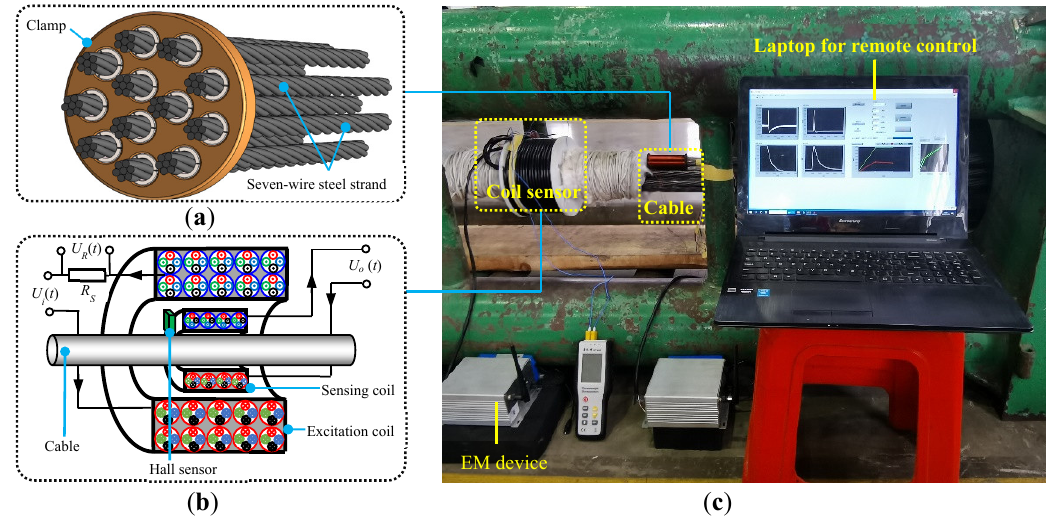
Figure 1. Experimental set-up for calibration: ( a ) cable composed of a bundle of seven-wire steel strands, ( b ) coil sensor, and ( c ) experimental set-up.